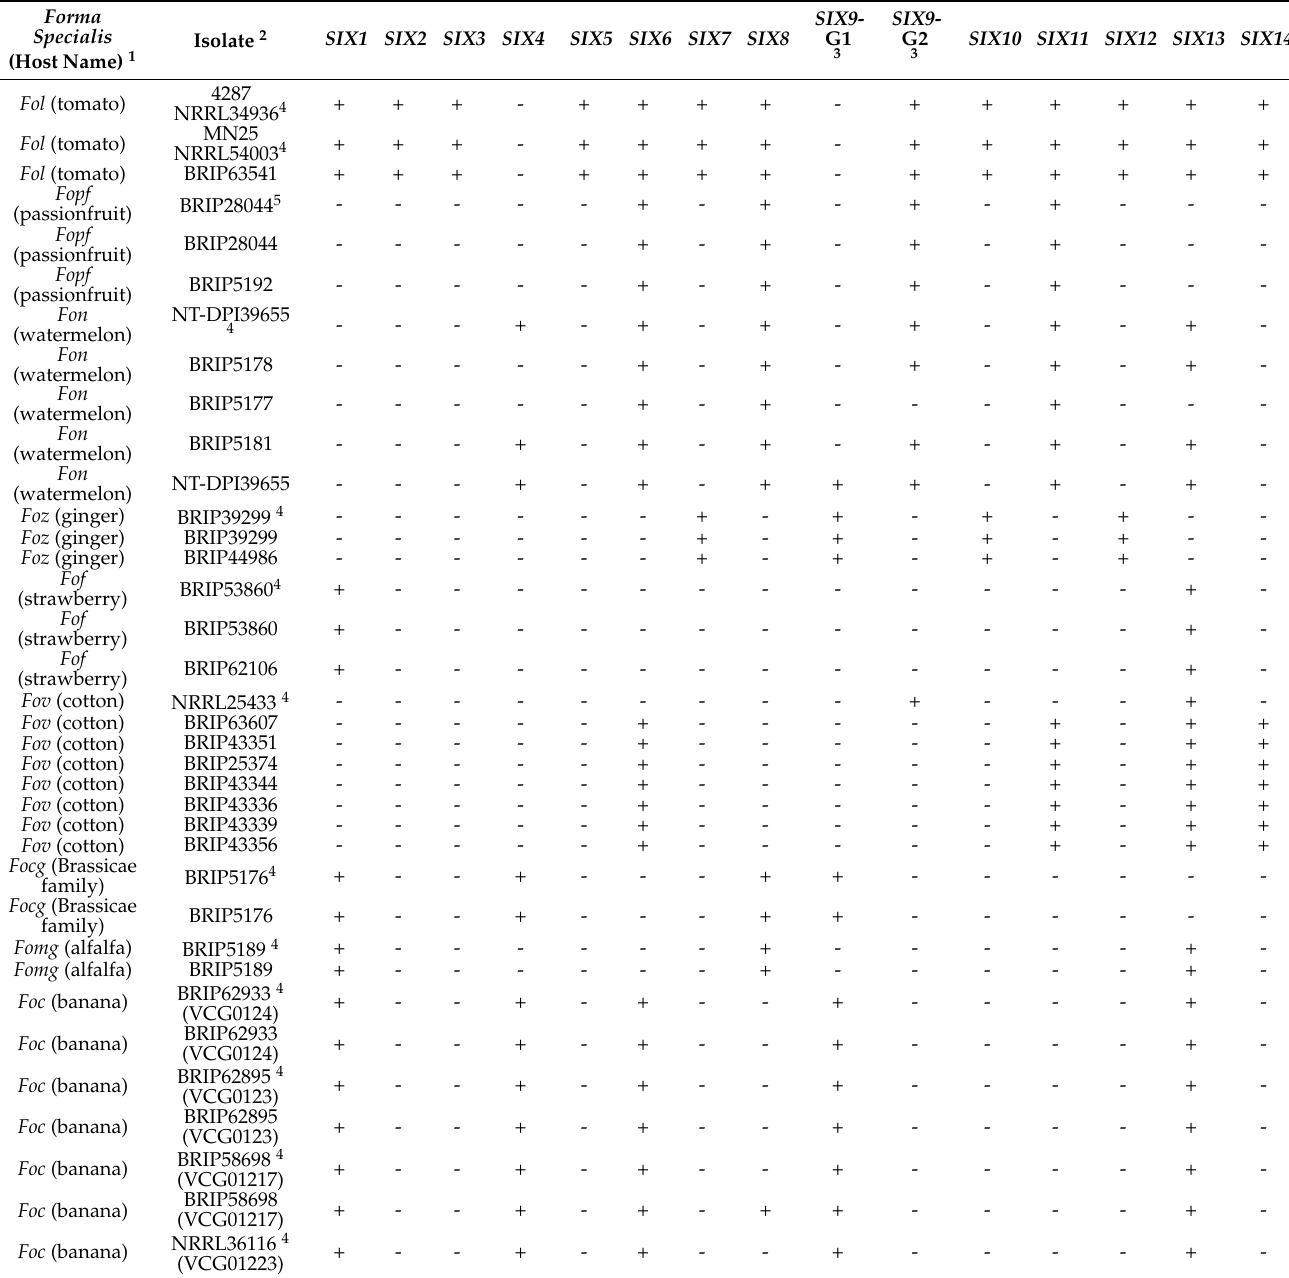
Table 2. A comparison of the secreted in xylem ( SIX ) gene profiles of the formae speciales in F. oxysporum by either querying reference genomes or screening by PCR with universal SIX gene primers developed for this study and confirmed by DNA